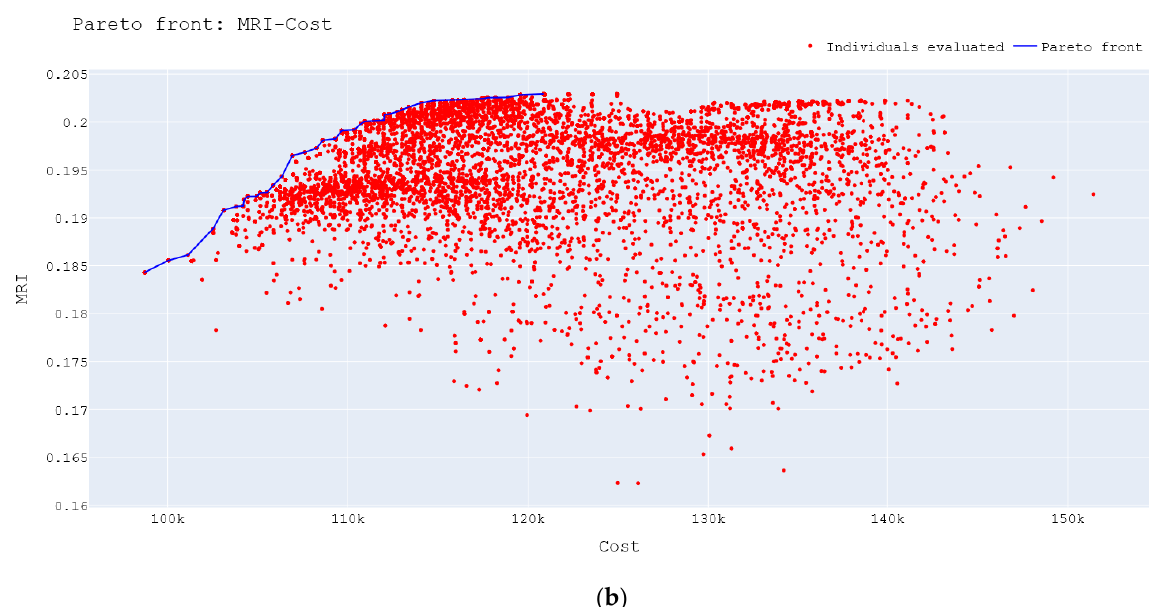
Figure 7. ( a ) Pareto frontier: Spectral clustering algorithm and MRI + investing cost objective function; ( b ) Pareto frontier: Girvan–Newman algorithm and MRI + investing cost objective function.